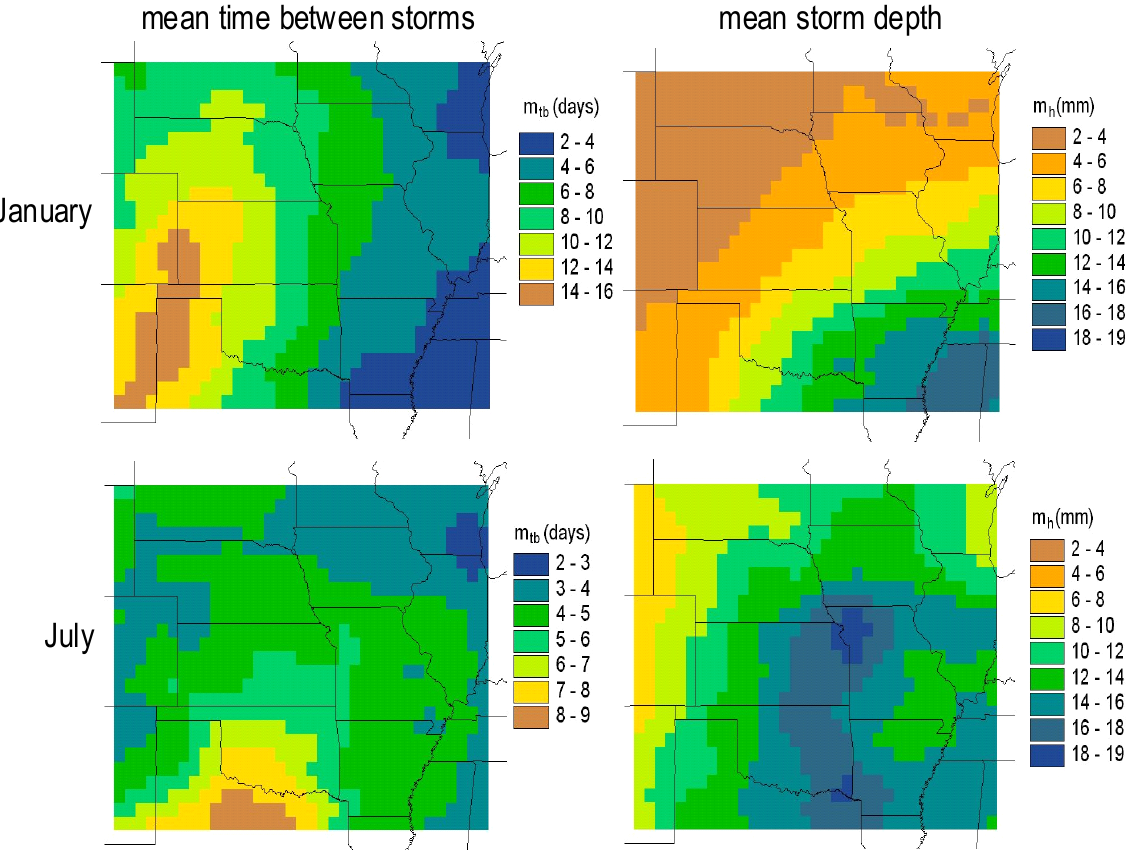
Fig. 14. Estimates of two of the statistics of the Poisson rectangular-pulse stochastic precipitation model for January and